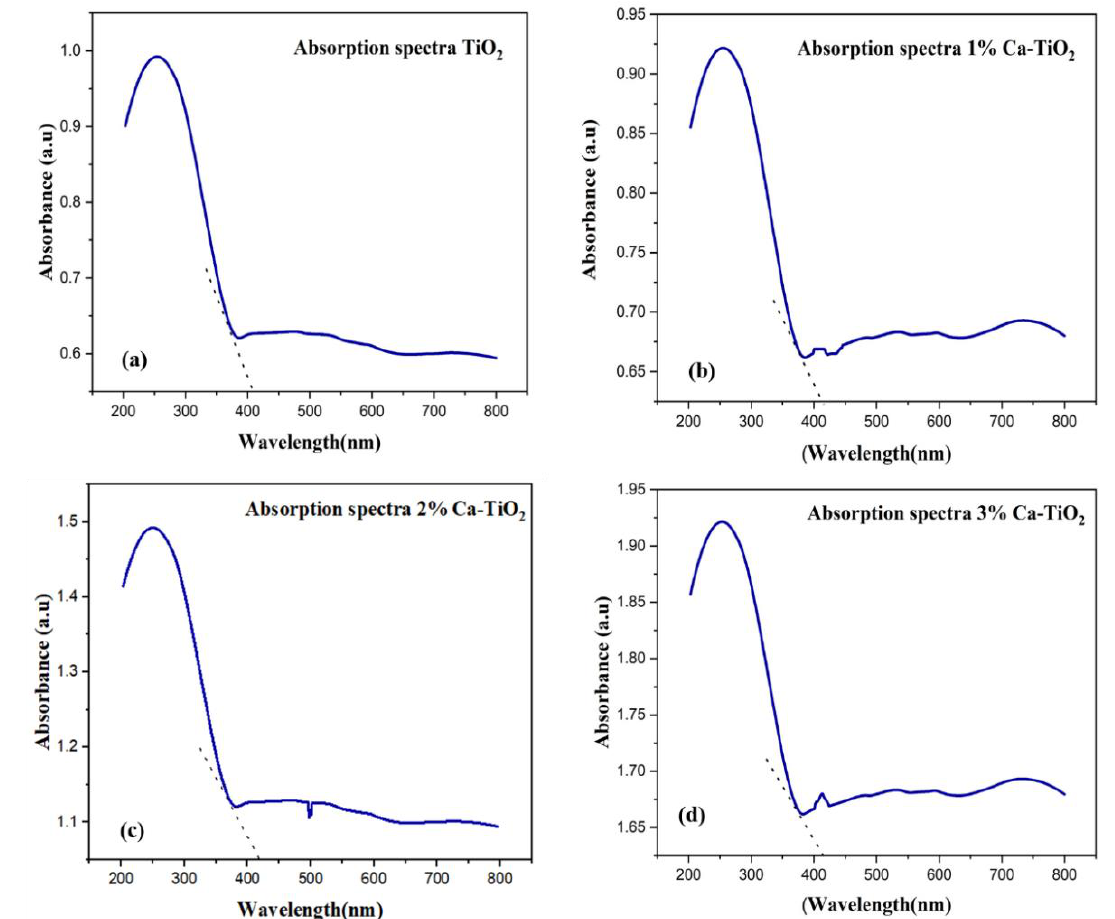
Figure 6. Absorption ( a ) TiO 2 , ( b ) 1% Ca-TiO 2 , ( c ) 2% Ca-TiO 2 , and ( d ) 3% Ca-TiO 2.